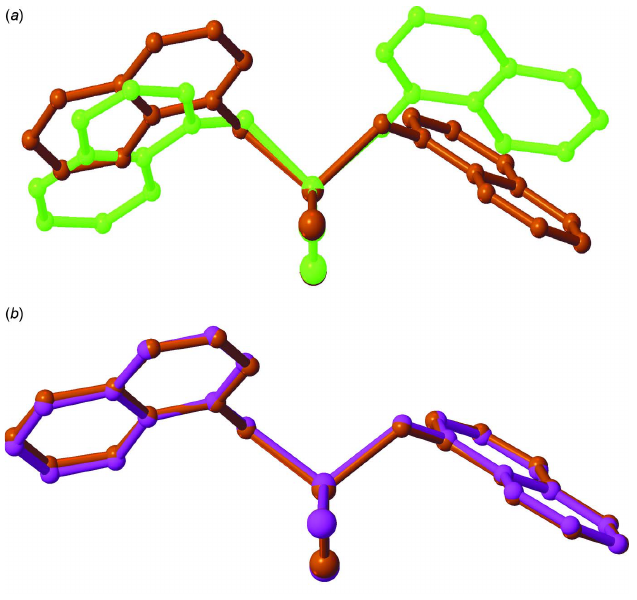
Figure 4 ( a ) Molecular overlay of compound ( I ) (green) and compound ( II ) (brown). ( b ) Molecular overlay of compound ( II ) (brown) and compound ( III )